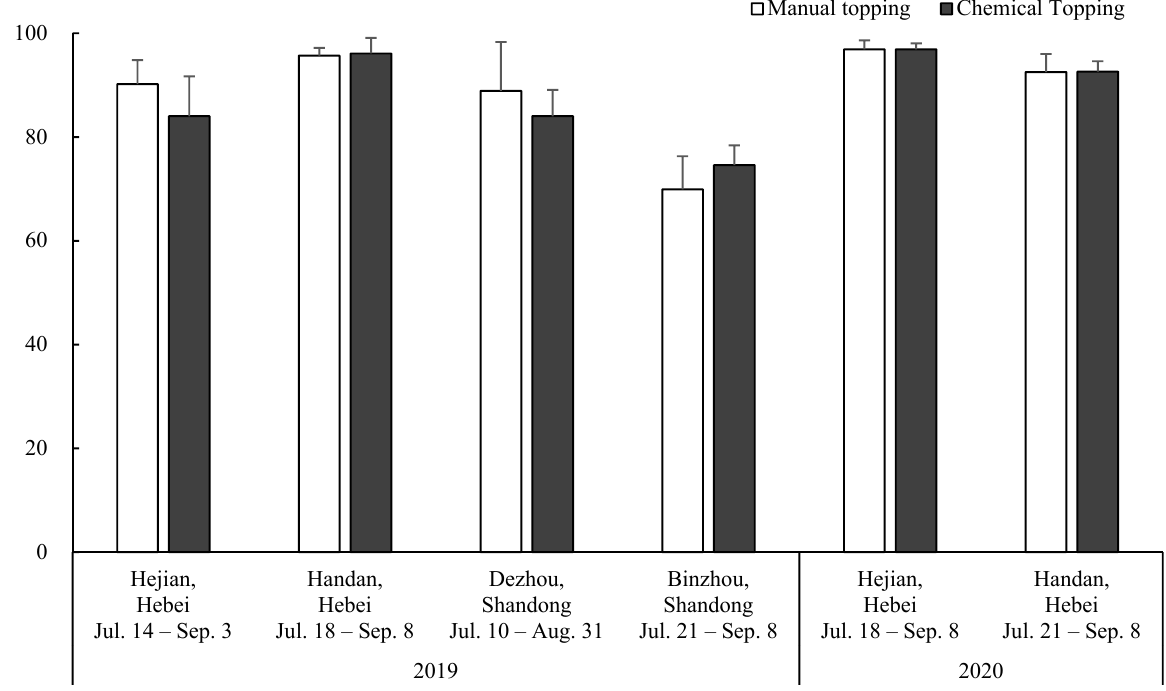
Figure 3. Effect of topping treatments on the opening percentage of tagged bolls (BOP). The young bolls were tagged on the first day of bloom in July, and BOP was determined after about 50 days in September; t -tests were used to compare the means for manual topping and chemical topping at the 0.05 probability level.